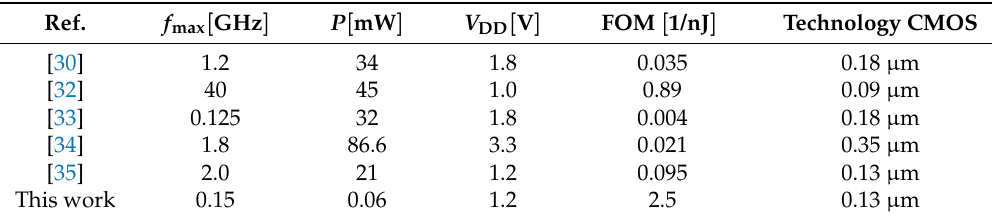
Table 1. Performance comparisons with other reported clock